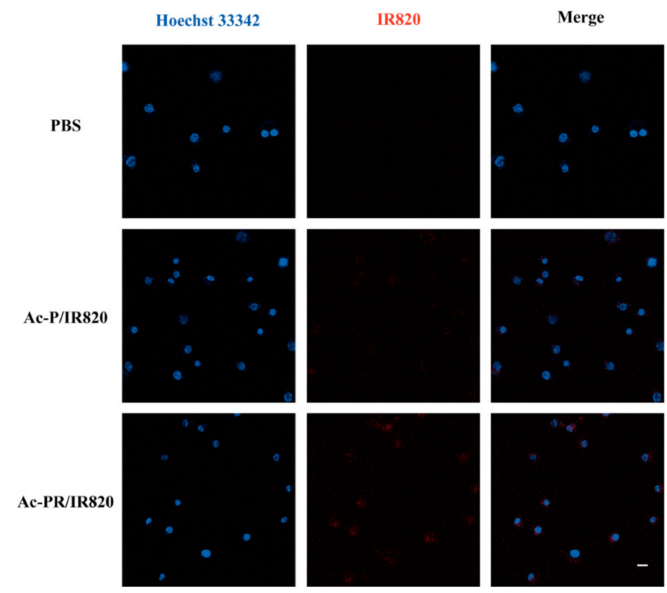
Figure 7. Confocal fluorescence images of U87MG cells after 6 h co-incubation with IR820-loaded dendrimers. Cells treated with PBS were tested as control. The fluorescence of Hoechst 33342 and IR820 were pseudo-labeled with blue and red, respectively. Scale bars: 20 µ